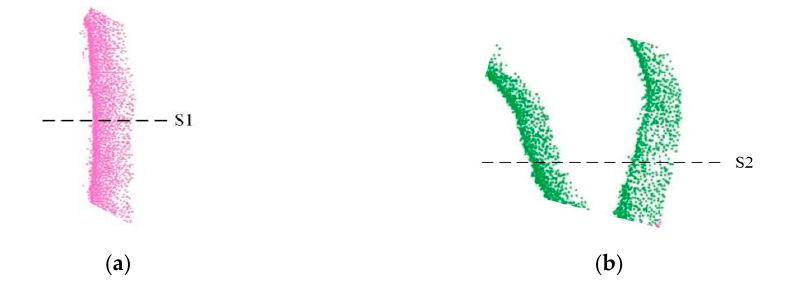
Figure 4. Spatial connectivity analysis to the neighboring point set. ( a ) The number of connected component is 1; ( b ) the number of connected components is 2.